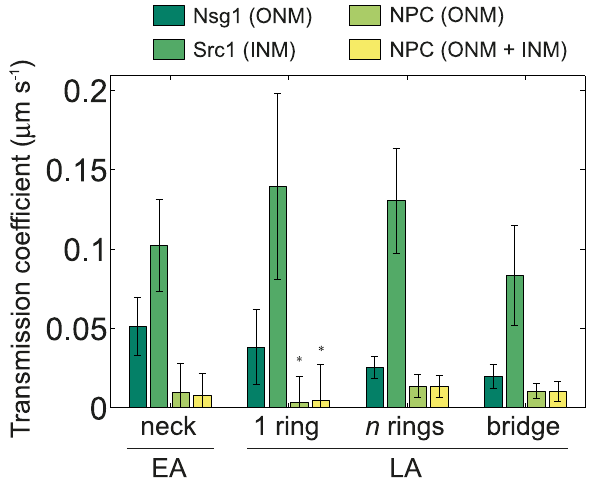
Figure 4. Barrier permeabilities of different specialised lipid domain configurations and for maker proteins at the ONM and INM. The transmission coefficient of the barrier depends directly on the partition coefficient and the diffusion rate within the domain, and is inversely dependent on its thickness (see Methods). The error bars are associated to the heterogeneous distribution of surface areas (21 nuclei in EA and 34 in LA). For the single ring configuration in LA, a ring of 100 nm wide was assumed for diffusion of NPCs (asterisks). For the NPC, we considered both scenarios where the domain lies only at the ONM or at both ONM and INM. Effective diffusion coefficients were fixed as in Table S2 and we fixed P out =100% in all cases. The corresponding P in values are shown in Table